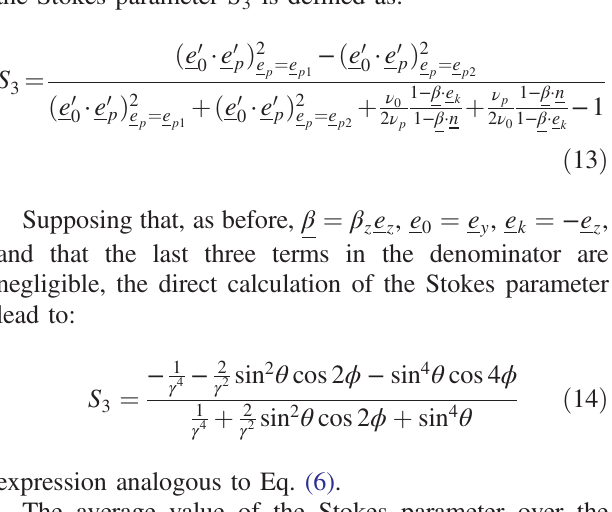
FIG. 5. SPARC case (beam 1): (a) Total number of emitted photons, (b) relative bandwidth and (c) average Stokes parameter with a linearly ( S 3 ) and circularly ( S 2 ) polarized laser as functions of the acceptance angle θ with parameters similar to the SPARC one in the first phase of the experimental operation. Simulation done with